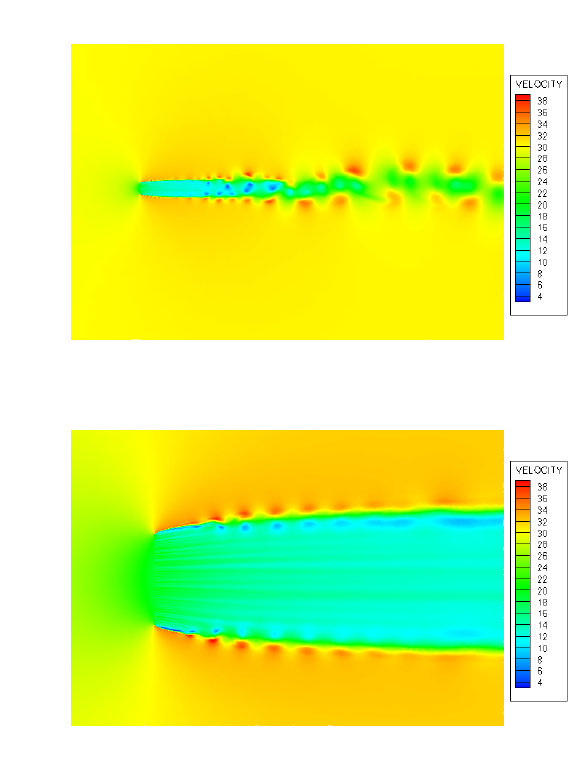
Fig. 5. The distribution of the pressure for the porous media for 20 ms − 1 .